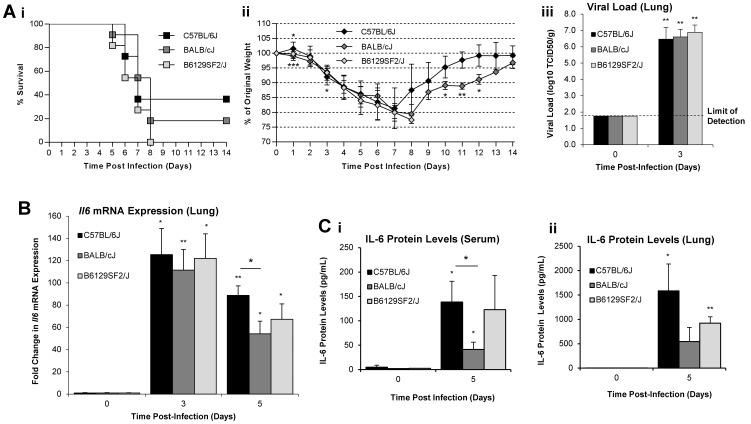
Severe A/Mexico/4108/2009 (H1N1pdm) infection triggered increased IL-6 expression in C57BL/6J, BALB/cJ, and B6129SF2/J mice.Survival curves for C57BL/6J (closed squares), BALB/cJ (grey squares), and B6129SF2/J (open squares) mice infected intranasally with 104 EID50 A/Mexico/4108/2009 (H1N1pdm). n = 11 for all three groups. The logrank test (α = 0.05) was used to ascertain significance in differences in survival (Ai) [43]. Average weight curve for C57BL/6J (closed diamonds), BALB/cJ (grey diamonds), and B6129SF2/J (open diamonds) mice. Vertical error bars indicate ±1 standard deviation. n = 17 for all groups. Asterisks below the curves indicate significant difference between C57BL/6J weights and BALB/cJ weights, asterisks above the curves indicate significant difference between C57BL/6J weights and B6129SF2/J weights. No significant differences between BALB/cJ and B6129SF2/J weights (Aii). Viral load in lung homogenates collected at days 0 and 3 pi. n = 3 for all groups. Infection of Madin-Darby Canine Kidney cells was employed to measure viral titers. The assay had a limit of detection of 101.75 TCID50/g of lung tissue, indicated by the dashed line. Vertical error bars indicate +1 standard deviation (Aiii). Il6 mRNA expression profiling in lung homogenates by qRT-PCR. Results are expressed as fold changes over expression in uninfected day 0 pi controls. n = 3 for each group. Vertical error bars indicate +1 standard deviation. (B). IL-6 expression levels in serum and lung homogenates. n = 3 for each group. Vertical error bars indicate +1 standard deviation (Ci&ii). The two-tailed, two-sample unequal variances Student’s t-test was used to ascertain significance (p-value <0.05 = *, p-value <0.01 = **, p-value <0.001 = ***).